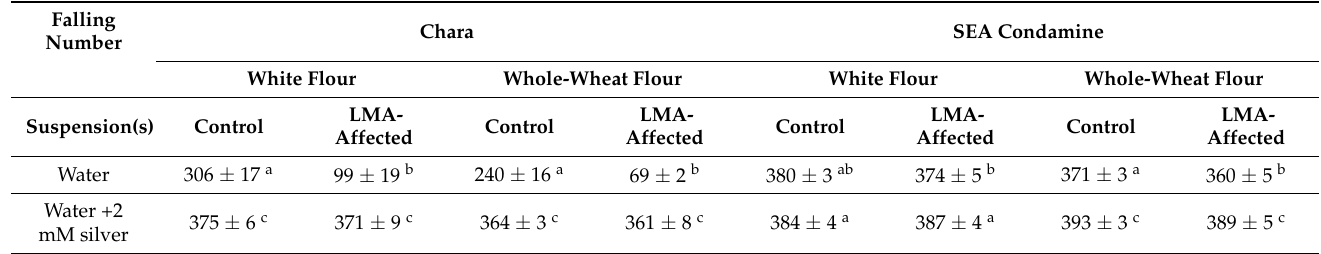
Table 1. Falling Number of control and LMA-affected flours. Results are presented as mean of biological quadruplicate ± standard deviation. FNs of the same cultivar and flour type marked by different letter indicate significant differences ( p ≤ 0.05). Falling